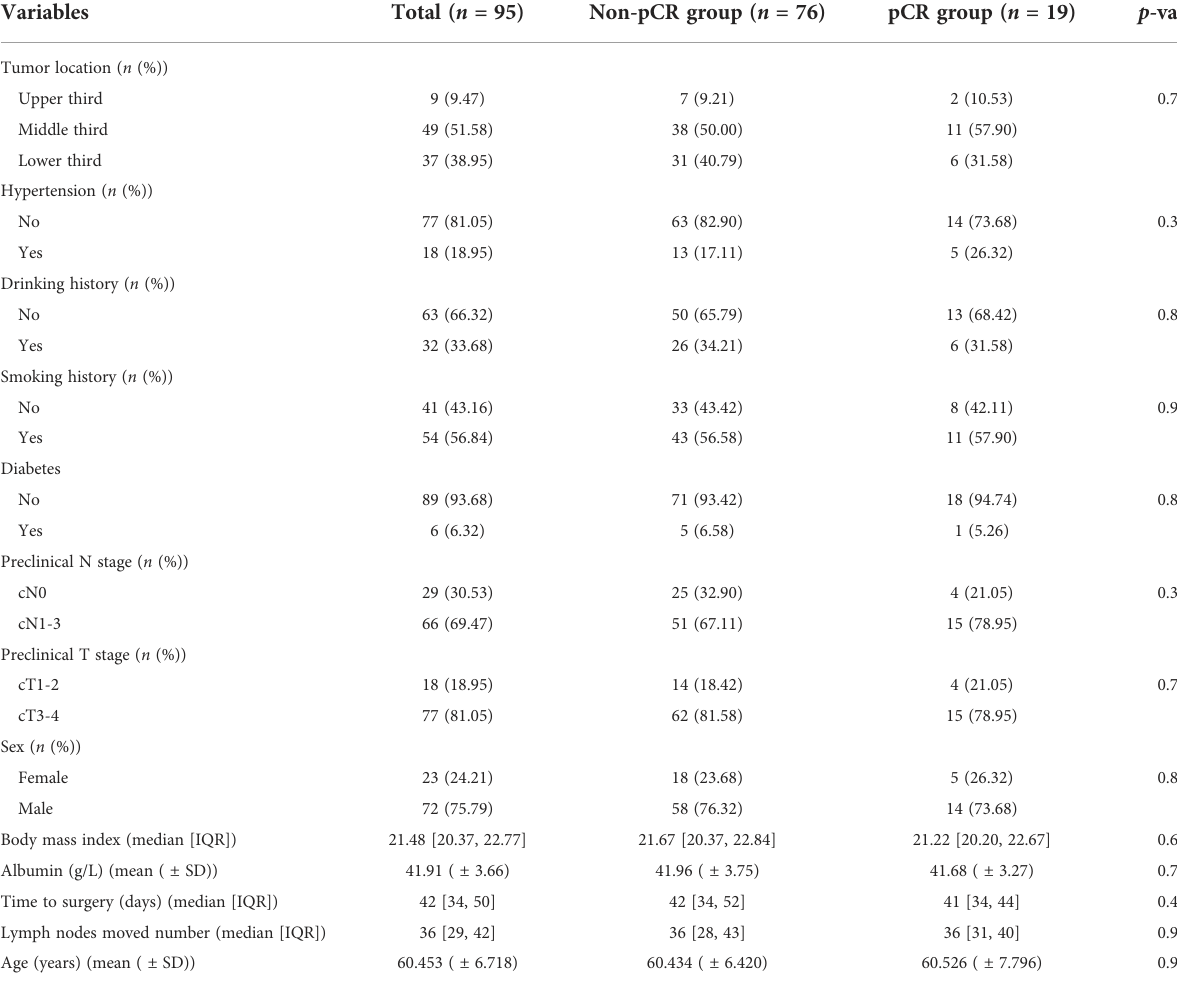
TABLE 1 Comparisons of baseline characteristics between the pCR group and the non-pCR